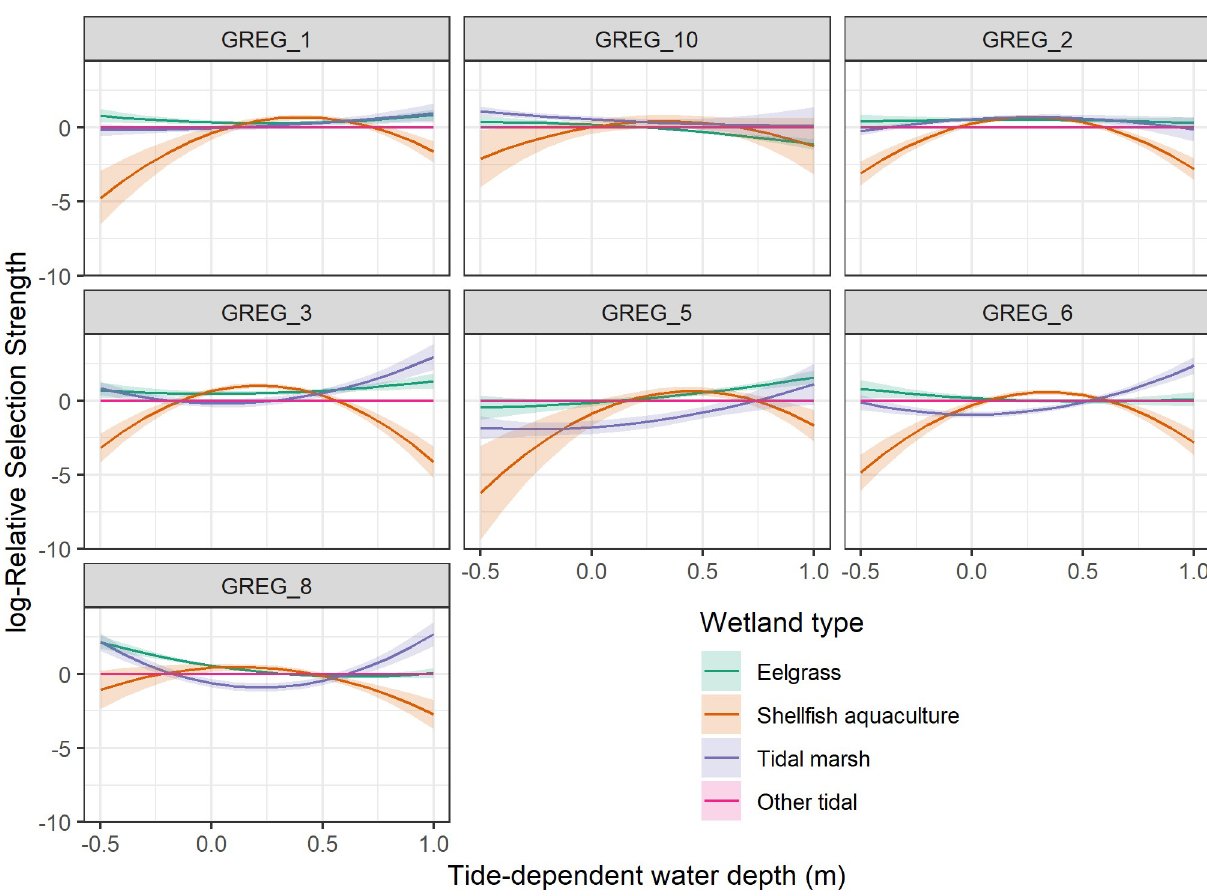
Fig 2. log-Relative selection strength and 95% confidence intervals of different tidal wetland types by seven GPS tagged great egrets at Tomales Bay, CA, 2017–2020, while accounting for tide-based changes in water depth. Other tidal areas (the reference level) were mostly unvegetated inter- and subtidal mud flats. Water depth represents the average depth in the 10 m 2 grid cell around where the bird was located. Negative values of water depth indicate the bird was located above predicted water